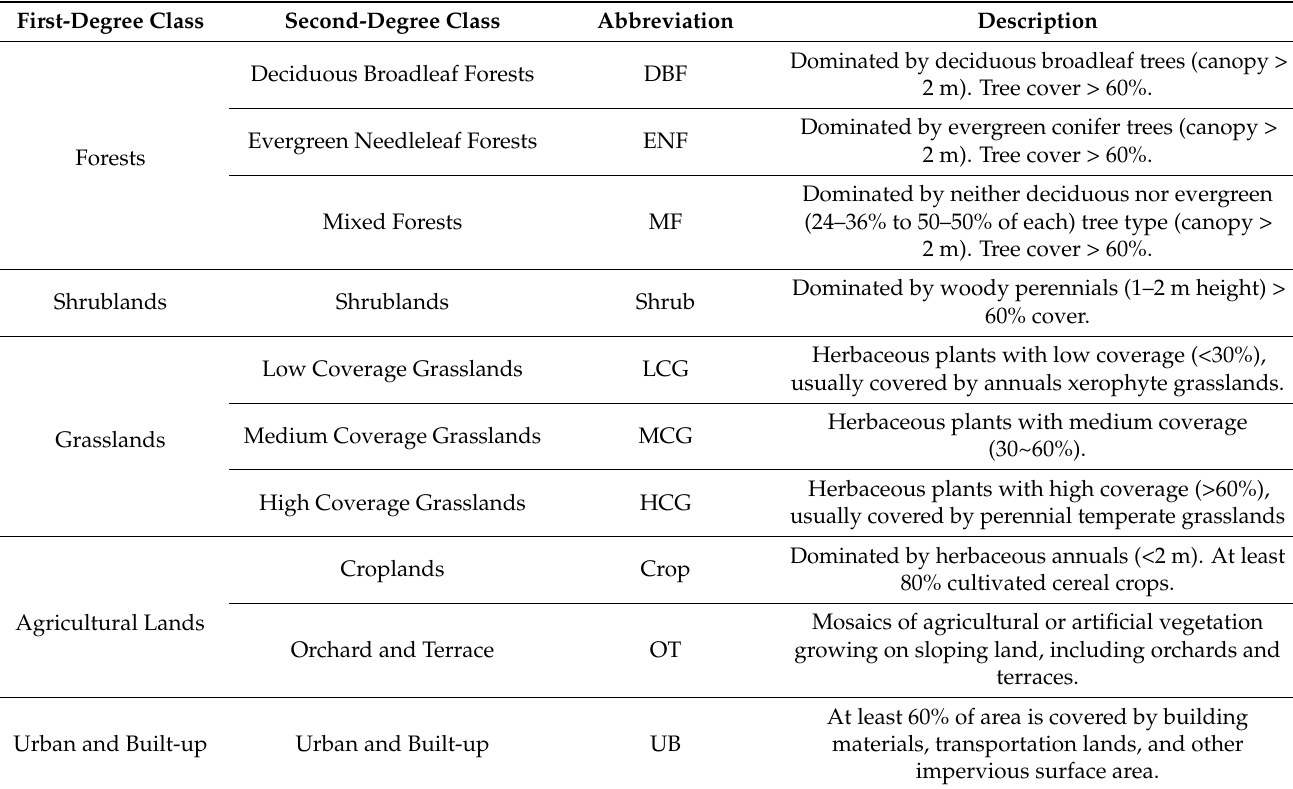
Table 2. The classification scheme of this